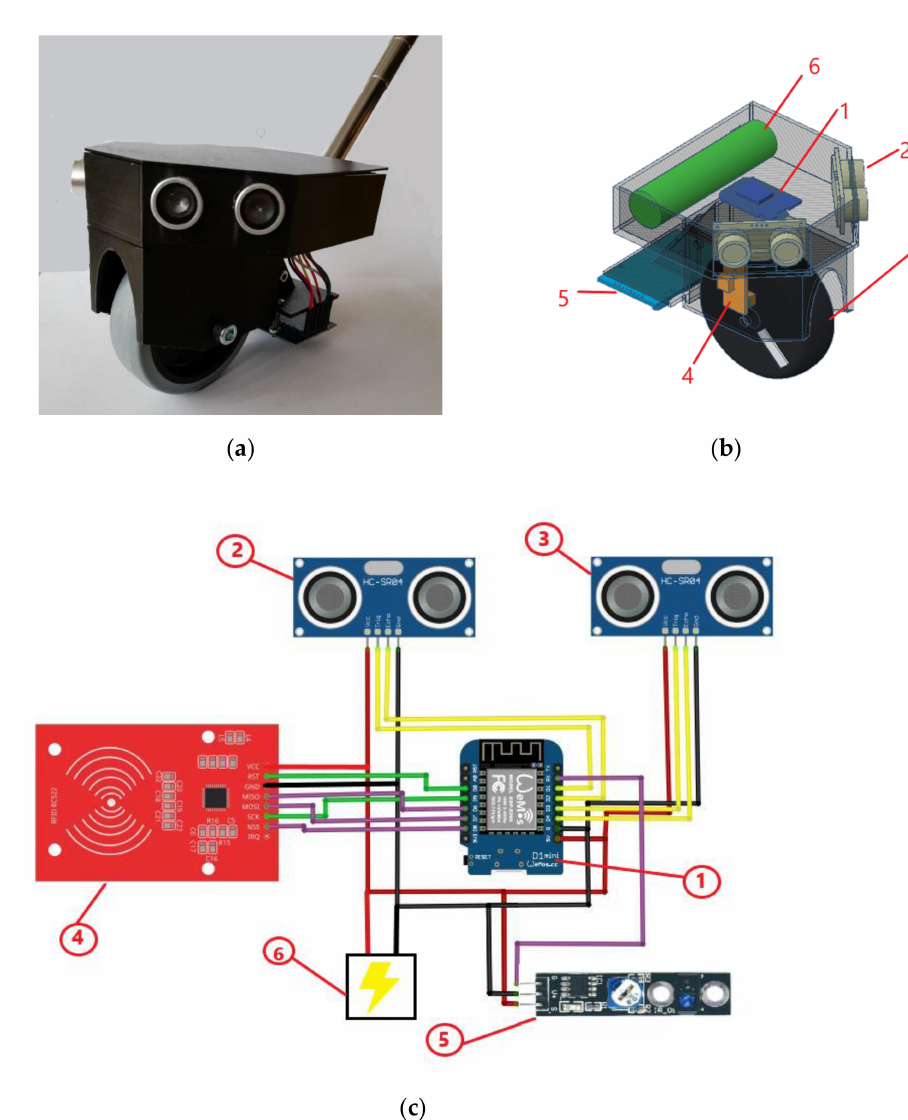
Figure 4. Prototype of the smart cane: ( a ) External view. ( b ) Electronic components: (1) Wemos board, (2) ultrasonic sensor, (3) rubber wheel, (4) optical sensor, (5) RFID reader, (6) battery. ( c ) Circuit diagram: (1) Wemos D1 mini module, (2) HC-SR04 ultrasonic sensors from the left side, (3) HC-SR04 ultrasonic sensors from the right side, (4) MRC522 RFID reader, (5) TCRT5000e reflective optical sensor, (6) 5 V portable power